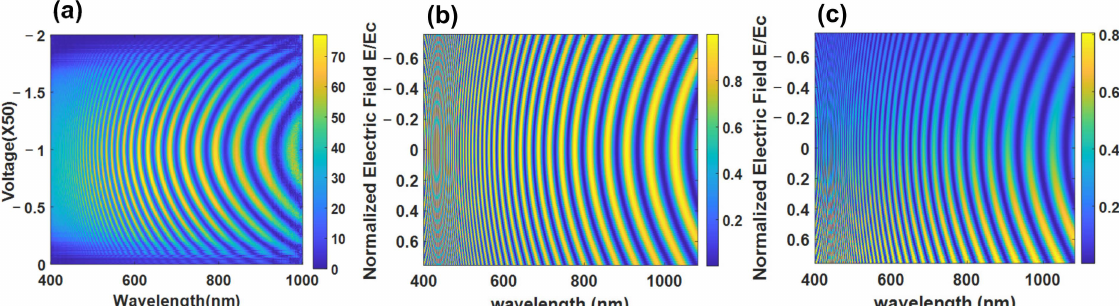
Figure 7. Spectral modulations of 131 µ m DHFLC device while ( a ) represents the measured transmission for β = 45 degrees; ( b ) shows the simulated transmission for β = 45 degrees; ( c ) shows the simulated transmission for β = 22.5 degrees while the color of the fringes represents the transmission coefficient